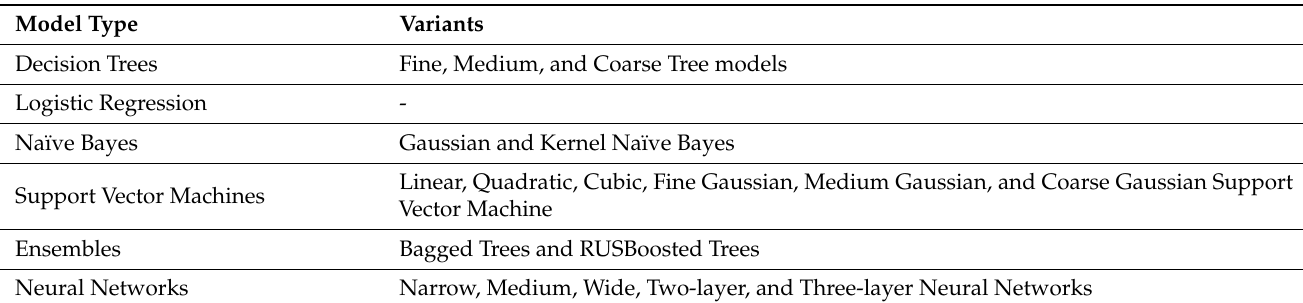
Table 6. Machine Learning models used in the Classification Learner